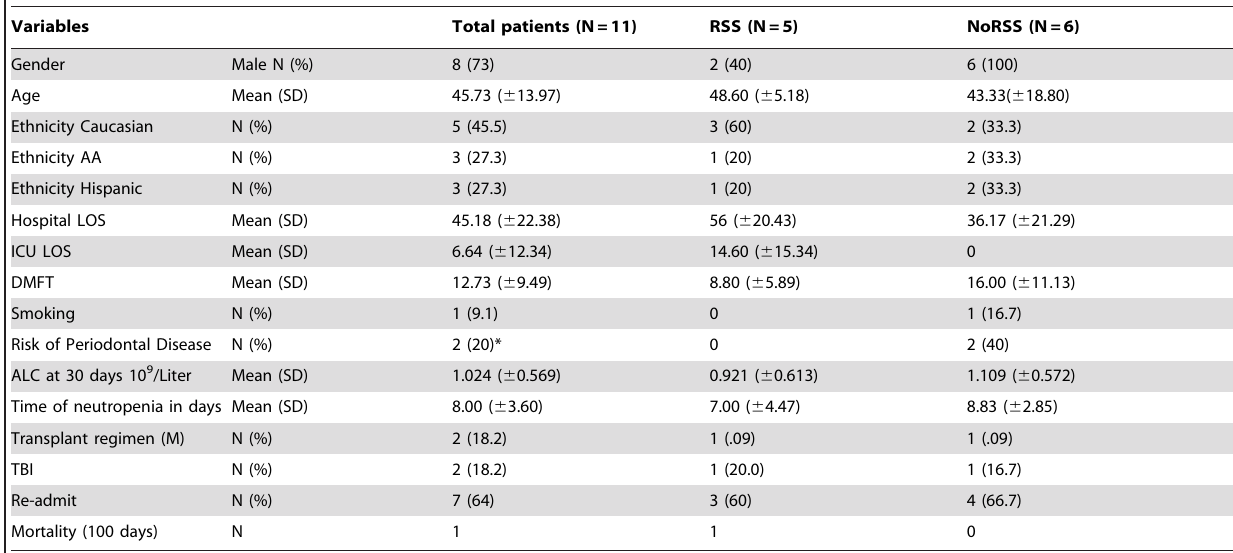
Table 2. Characteristics of 11